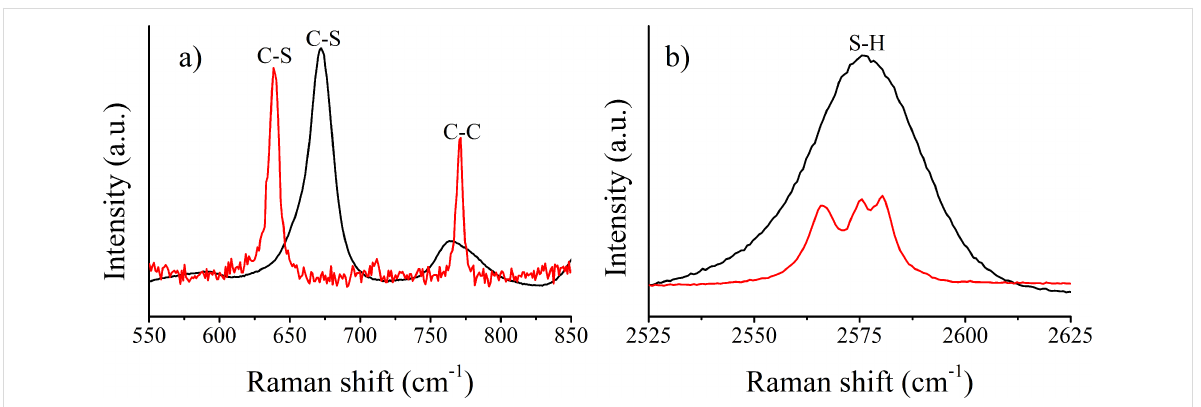
Figure 3: a) Comparison between unbound (i.e., free) thiol and hybrid SAM-MWCNTs for C–S and C–C elongations, b) comparison between unbound thiol and hybrid SAM-MWCNTs for S–H elongations. Black line: thiol (C 2 H 6 O 2 S); red line: